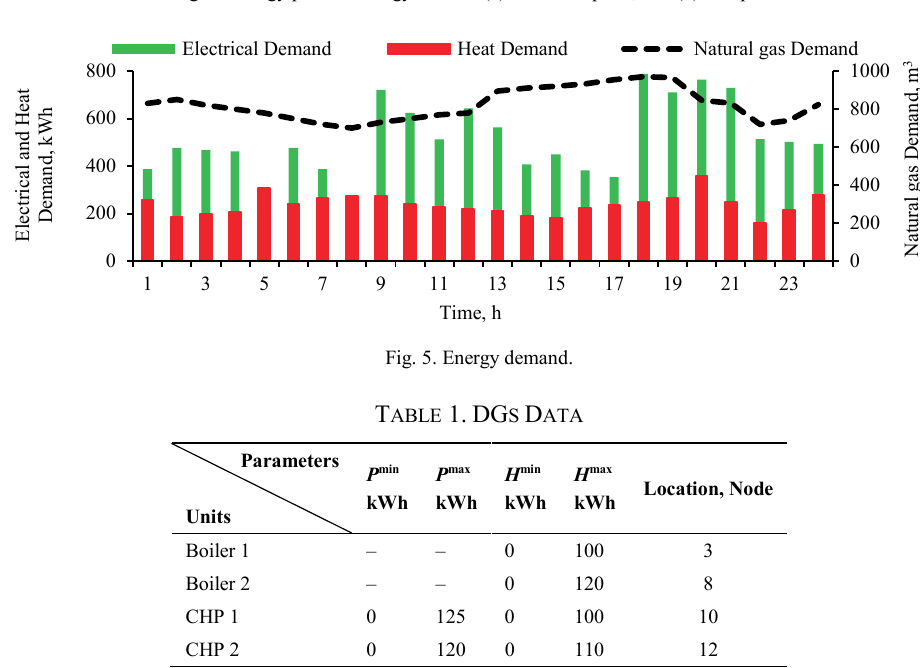
Fig. 4. Energy price in energy market: (a) Electrical price, and (b) Gas price.